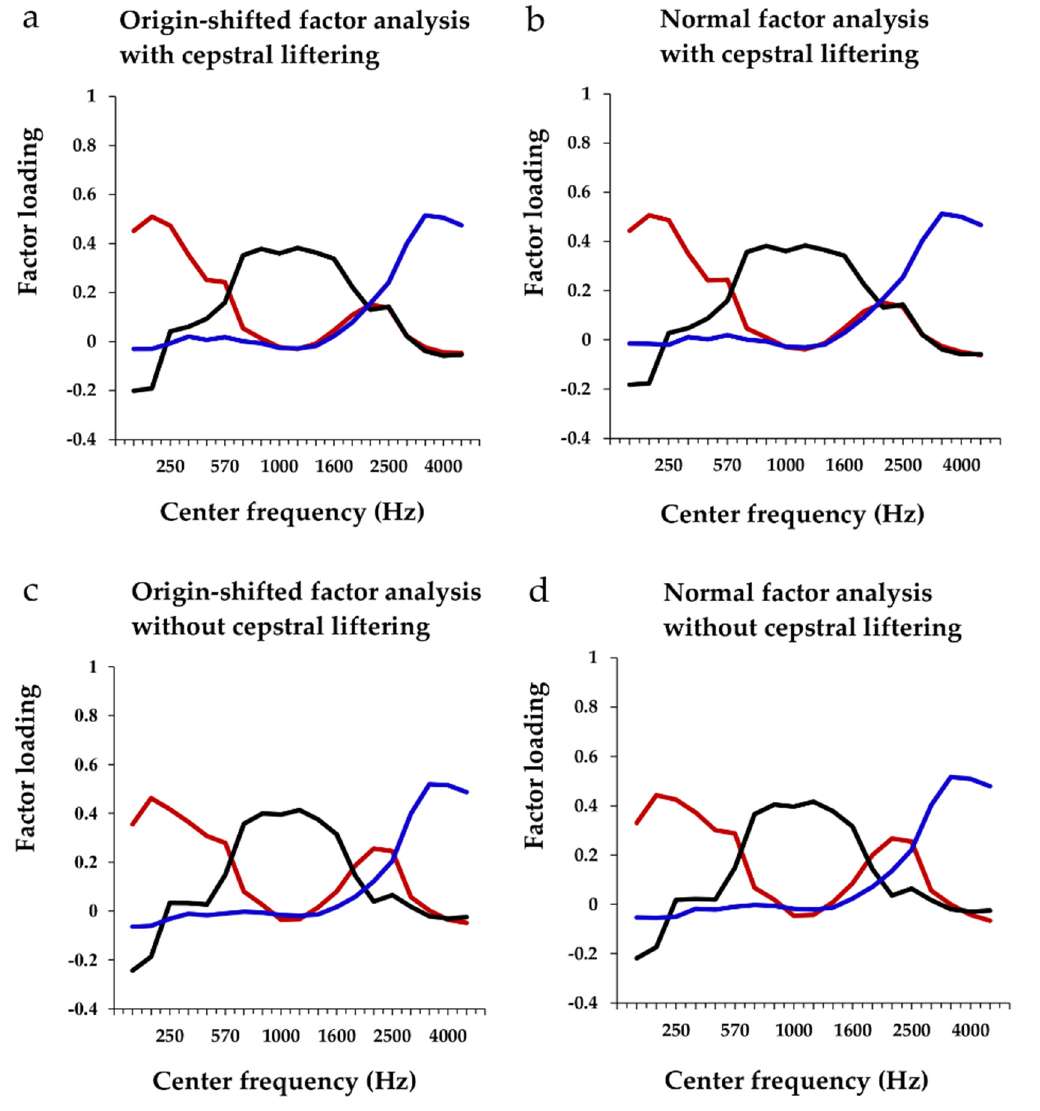
Figure 1. Factor loadings of the three extracted spectral factors of 200 English speech samples from three native speakers. Four di ff erent factor analyses were performed: ( a ) origin-shifted factor analysis with cepstral liftering, following [12]; ( b ) normal factor analysis with cepstral liftering; ( c ) origin-shifted factor analysis without cepstral liftering; ( d ) normal factor analysis without cepstral liftering.